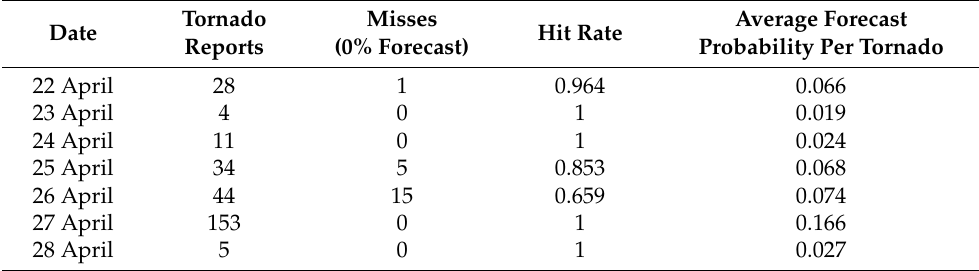
Figure 6. PEP bulletin from the 27 April 0600 UTC run of the 4-km regional ensemble valid for Birmingham, AL. Variables listed on the left hand side, with probabilities (percent) of exceedance for each valid time in rows to the right of the label. Yellow and red coloring designed to draw user attention to higher probabilities. Note the elevated potential for lightning, strong surface winds, large hail, and tornadoes. Table 1. 4-km ensemble tornado probability forecast (within 20 nautical miles for the preceding hour) performance for 22–28 April 2011. Forecasts generated 0600 UTC, valid for the 2100-0300 UTC (39–45 h lead time) period. Preliminary observed tornado reports as compiled by the US National Weather